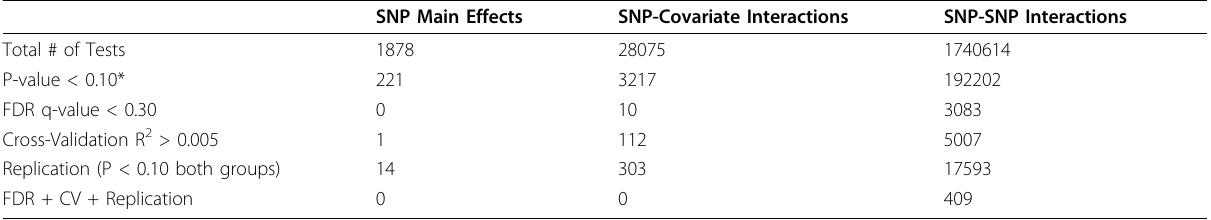
This table outlines the number of associations (single SNP, SNP-covariate interactions, and SNP-SNP interactions) passing each level of multiple testing criteria (False Discovery Rate (FDR), 4-fold cross validation (CV) repeated and averaged 10 times, and internal replication in two subsets of the full dataset). The intersection of associations passing all three criteria reveals little overlap. *P-values for SNP main effects are from a 2 degree of freedom likelihood ratio test statistic. The SNP-covariate and SNP-SNP interactions p-values were determined from a likelihood ratio test comparing a full model (including all interactions and main effects) to a reduced model only containing main effects of covariates and/or SNPs.